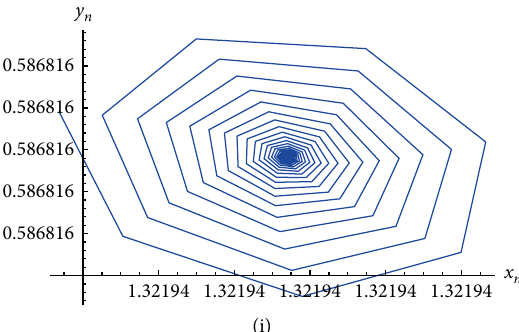
Figure 2: Phase portraits of the model (8). (a) with (0.06, 0.04). (e) (0.006, 0.004). (d) 𝜁 2 = 0.477 with (0.06, 0.04). (i) (0.06, 0.04). (h) 𝜁 2 = 0.4332